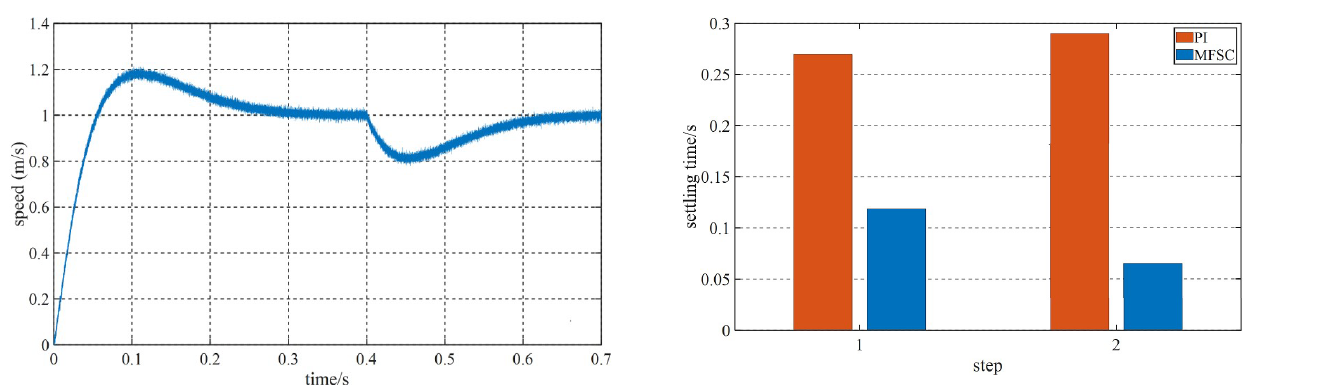
Figure 17. Speed waveform of sudden load in PI system.